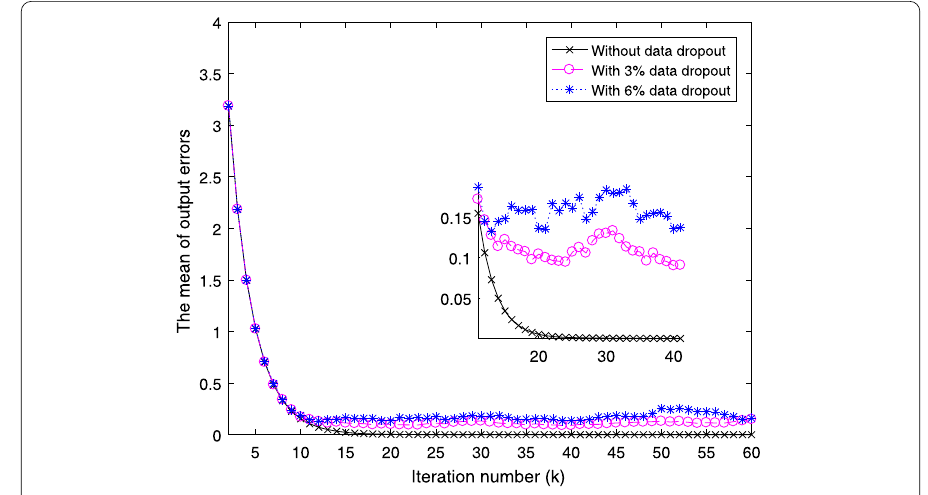
Figure 3 The mean of output errors compensated in time domain